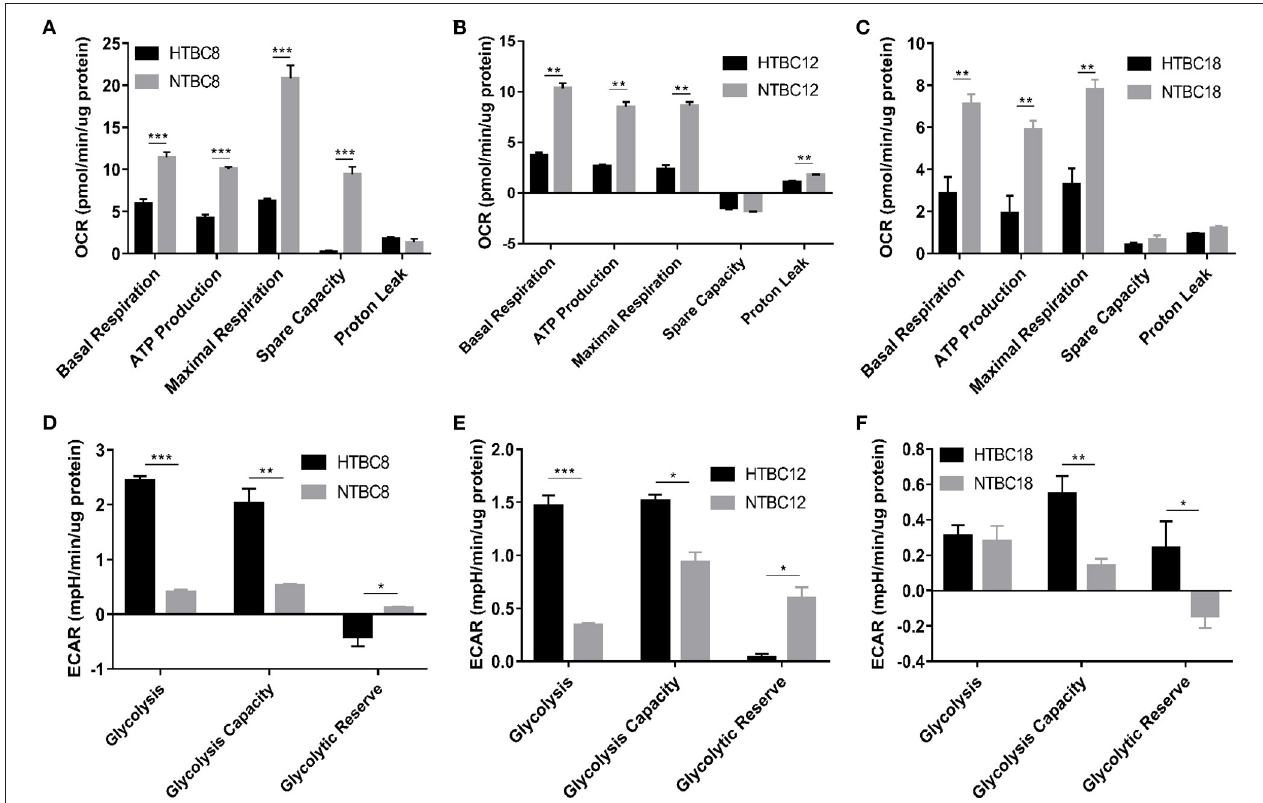
FIGURE 2 | The OCR and ECAR results at different embryo developmental stages of TBCs. (A–C) The OCR of TBC primary brain cells on days 8,12 and 18 of incubation under hypoxia and normoxia ( n = 3). (D–F) The ECAR of TBC primary brain cells on days 8, 12, and 18 of incubation under hypoxia and normoxia ( n = 3). HTBC, TBCs under hypoxia; NTBC, TBCs under normoxia. Data are indicated as the mean ± SEM. Asterisks represent significance compared to normoxia. * P < 0.05, ** P < 0.01, *** P < 0.001.